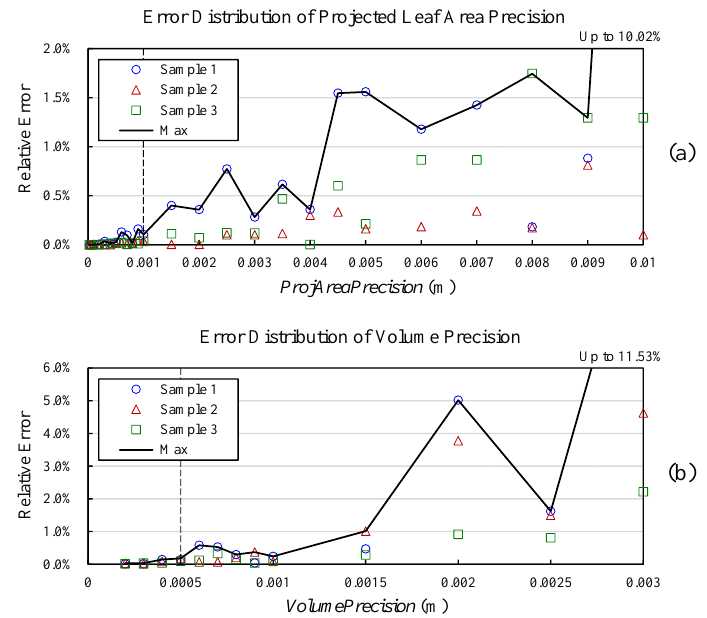
Figure 9. Precision parameters optimization for projected leaf area ( a ) and volume ( b ). The selected values are shown as dashed lines.